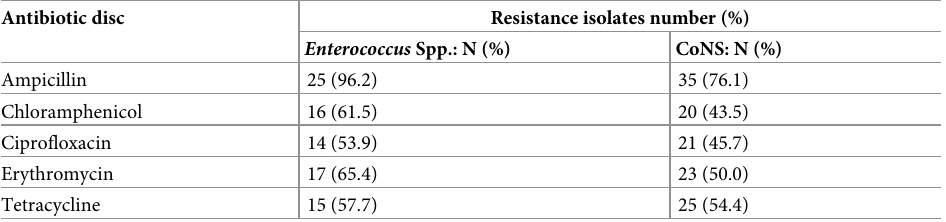
Table 3. Antimicrobial resistance profile of Enterococcus spp. and coagulase negative Staphylococcus spp. isolated among patients attending at FHSCH, Bahir Dar, Ethiopia, 2020. Antibiotic